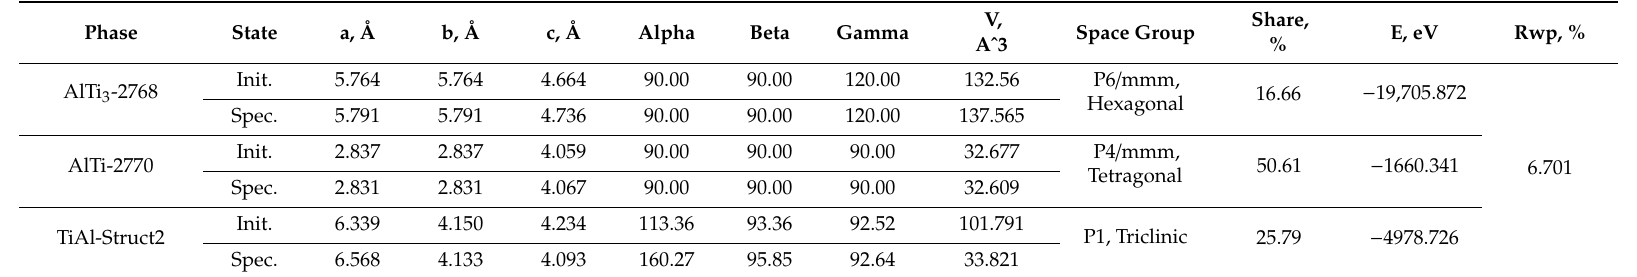
Table 3. Structural parameters of the lattices and the share of phases, and the convergence criterion of the TAT